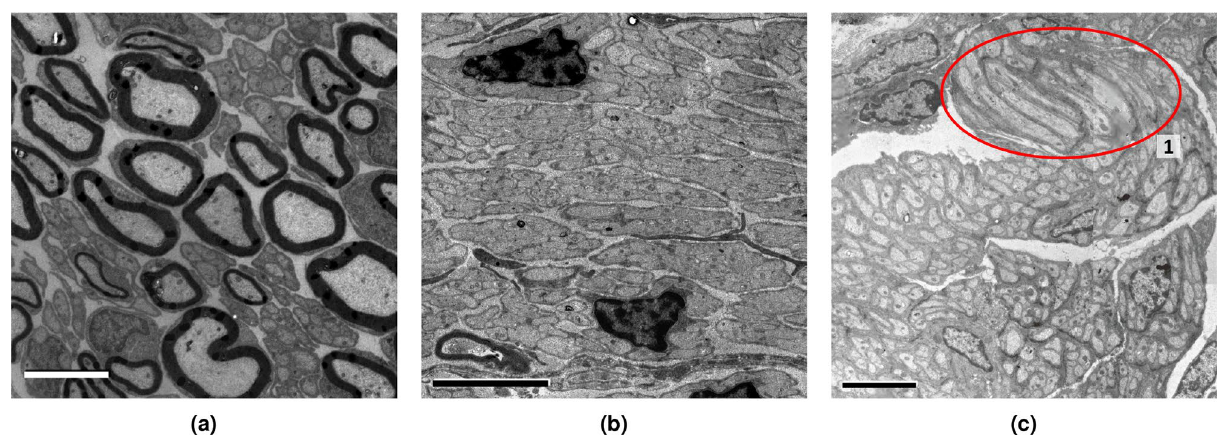
Figure 2. Images with different characteristics. ( a ) Myelin-rich regions with dark unmyelinated fibers (UMFs). ( b ) Low-contrast fibers. ( c ) Light UMFs in myelin-poor regions with a Remak bundle highlighted in ( 1 ). Scale bars: 4 µ